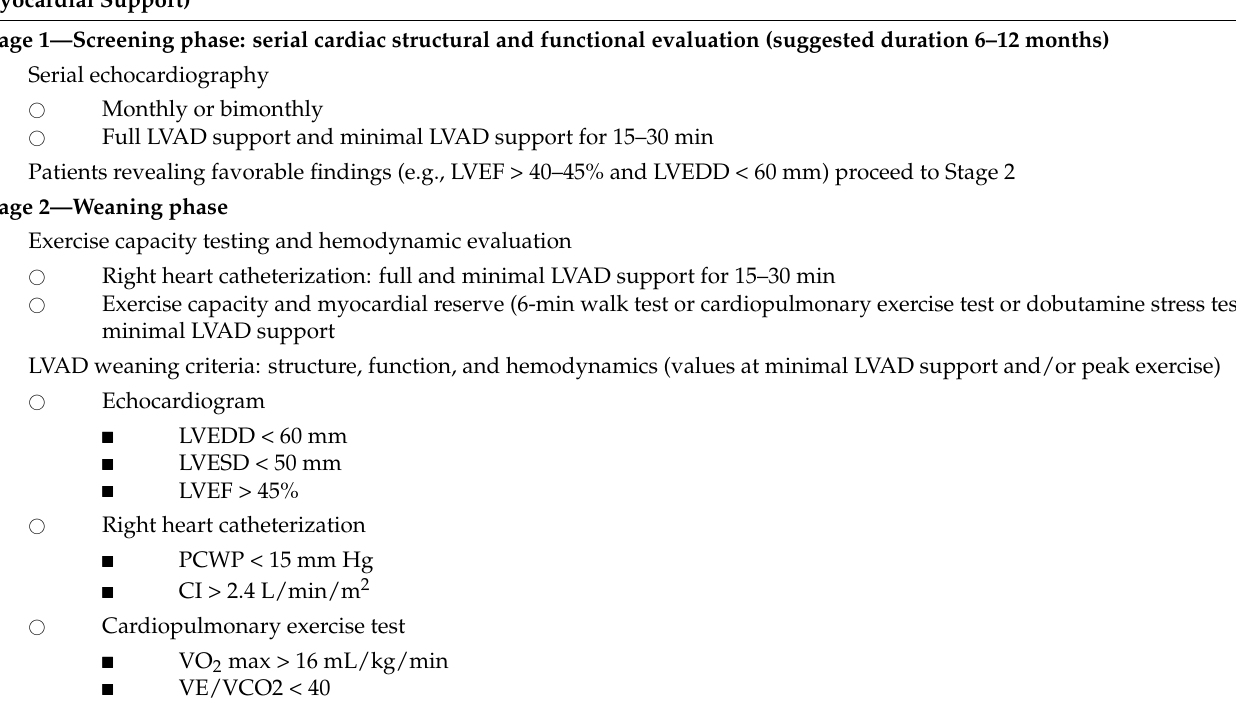
Table 2. Assessment of LVAD-supported patients for cardiac structural and functional cardiac improvement and potential device weaning. (Table reproduced from Drakos SG et al. Clinical myocardial recovery during long-term mechanical support in advanced heart failure: Insights into moving the field forward. J Heart Lung Transplant. 2016 Apr;35[4]:413–420) [43].